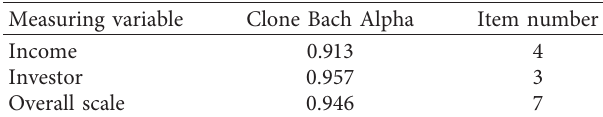
Table 2: Validity analysis.